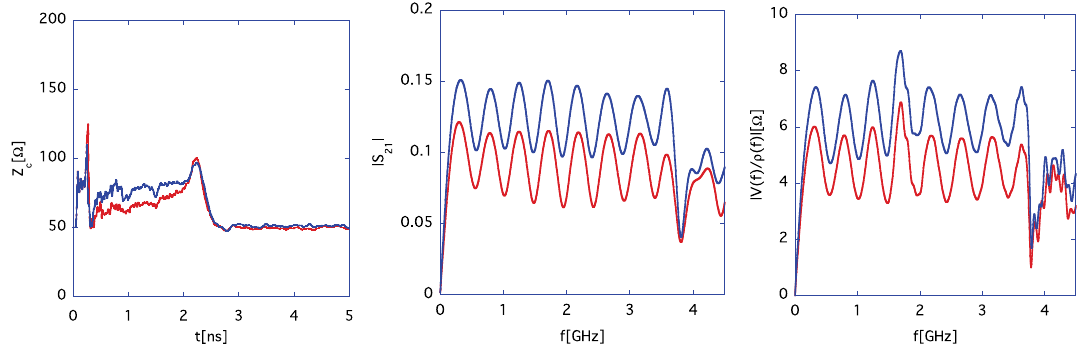
FIG. 21. The simulation results ( l ¼ 306 mm, 134 ϕ ) with artificial impedance mismatching to simulate the measurement results shown in Fig. 20: TDR (left), S 21 (middle) and the beam-induced voltage at the feedthrough divided by the beam distribution current for the triangle electrode (right) where the wake potential is calculated as a length of 3 m. The blue and the red lines show the result with and without apron,